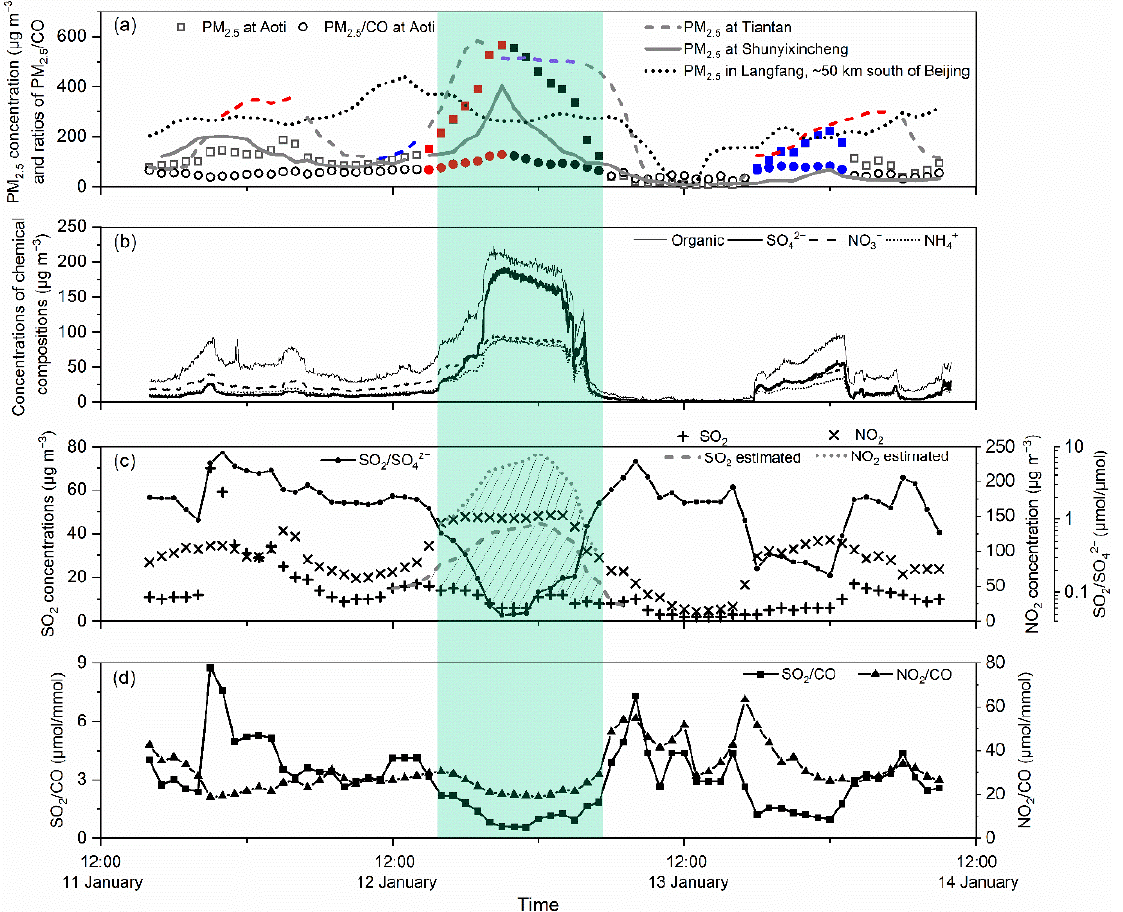
Figure 6. Temporal variations in different variables on 11–14 January 2019 at the Aoti site: ( a ) time series of hourly average mass concentrations of PM 2.5 at the Aoti site in comparison with those observed at the Tiantan and Shunyixincheng site, and in Langfang, and PM 2.5 /CO ratios in µg m –3 /mg m –3 at the Aoti site; ( b ) time series of organic, SO 42– , NO 3– , and NH 4+ concentrations in PM 2.5 at the U-site; ( c ) time series of SO 2 or theoretically accumulated SO 2 (gray short dotted line) and NO 2 or theoretically accumulated NO 2 (gray short dashed line) concentrations and molar ratios of SO 2 /SO 42– , the upper and lower shadow area represents the theoretically converted amounts of NO 2 and SO 2 to NO 3- and SO 42– , respectively; ( d ) time series of molar ratios of SO 2 /CO and NO 2 /CO.